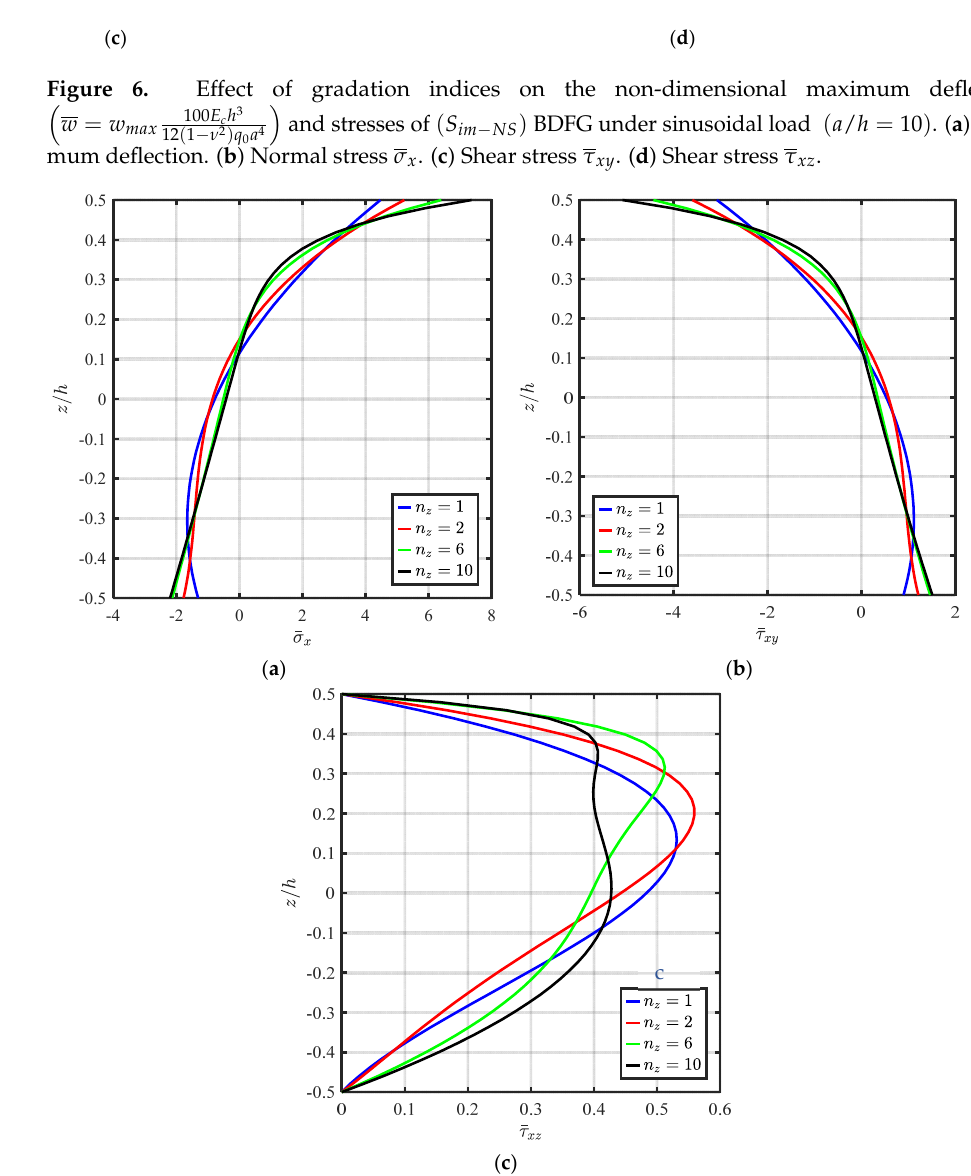
Figure 7. Non-dimensional stresses of ( S im − NS ) BDFG at different n z ( a / h = 10, n x = 0 ) . ( a ) Normal stress σ x . ( b ) Shear stress τ xy . ( c ) Shear stress τ xz